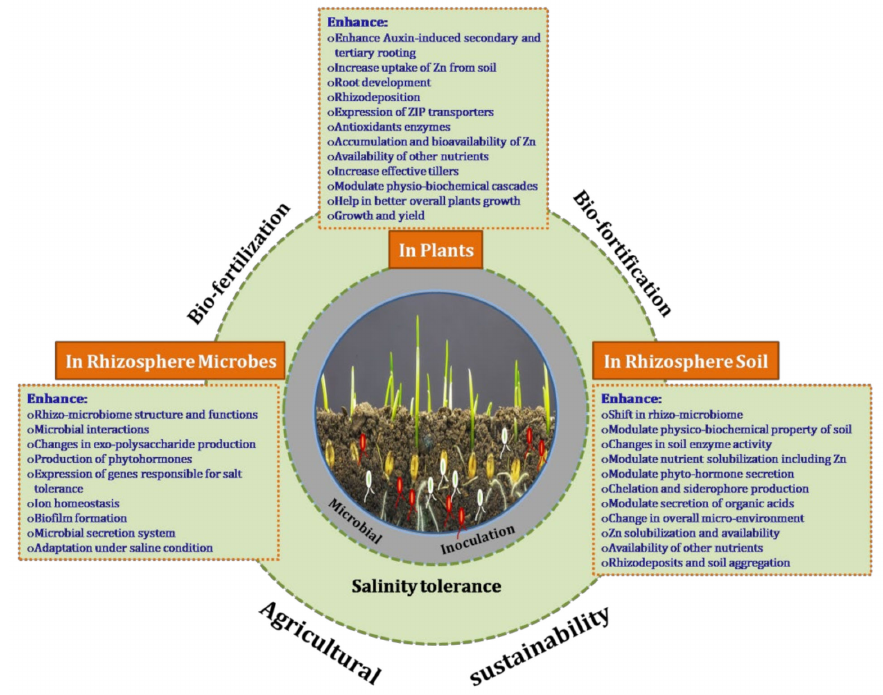
Figure 8. Schematic diagram representing holistic overview of microbial inoculation, T. harzianum and B. amyloliquefaciens on rhizosphere microbes, plants and rhizosphere soil at different crop growth